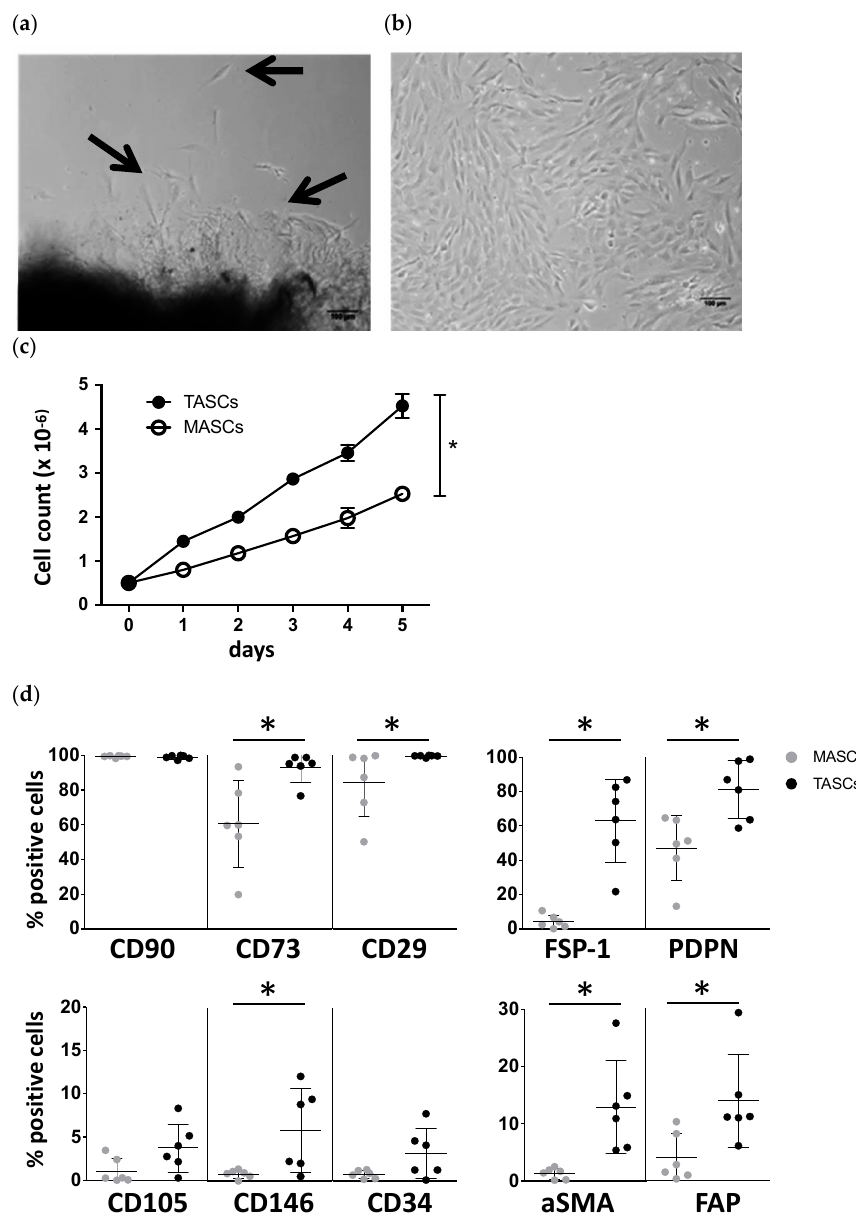
Figure 1 . Isolation and characterization of TASCs from primary sporadic colon cancers. ( a ) Representative TASC outgrow from tumor tissues two days after isolation. Arrows indicate cells outgrowing from tissue fragments. ( b ) Morphological appearance of TACs after 2-week culture. Magnification 20×; scale bar 100 μ m. ( c ) Growth kinetics of stromal cells isolated from tumor (TASCs) or from corresponding healthy colonic mucosa (MASCs). Data refer to three independent experiments performed with different TASC/MASC matched preparations. * p ≤ 0.05. ( d ) Phenotypic analysis by flow cytometry of TASCs and corresponding MASCs isolated from six different colon cancer samples. Percentages of cells positive for the indicated markers are reported Means ± SD are indicated by bars. Statistical significance of differences between TASCs and MASCs was evaluated by Wilcoxon signed rank test, * p ≤ 0.05.